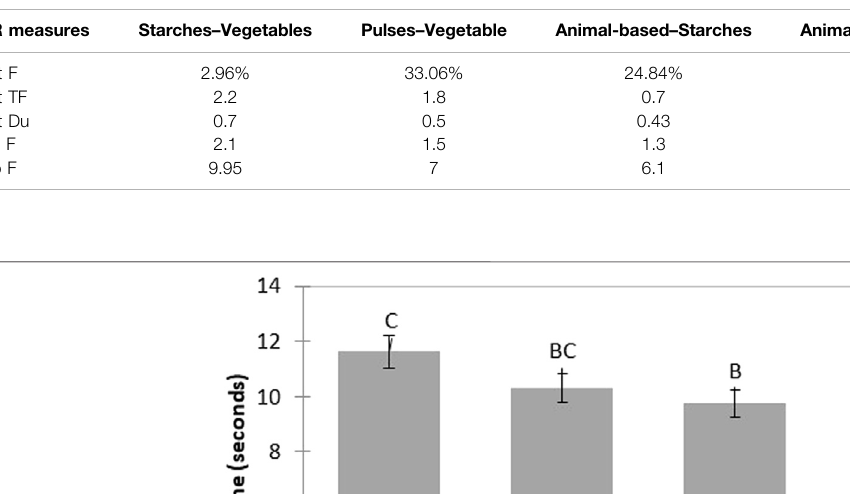
TABLE 5 | Gaze behavior in seconds converted into ratios, eye-tracking measures of consumers toward each AOI (food-group) in the screening of the ready-to-eat shelf. First fi xation (1st F, in %), Time to First Fixation (1st TF, in sec), First Fixation Duration (1st Du, in sec), and Number of fi xations (NbF).